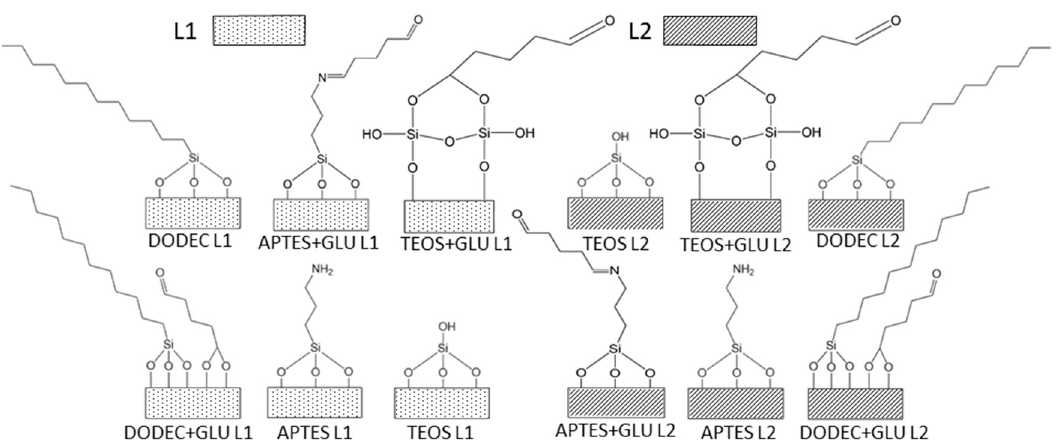
Figure 2. Surface functionalization representations of the adsorbents .